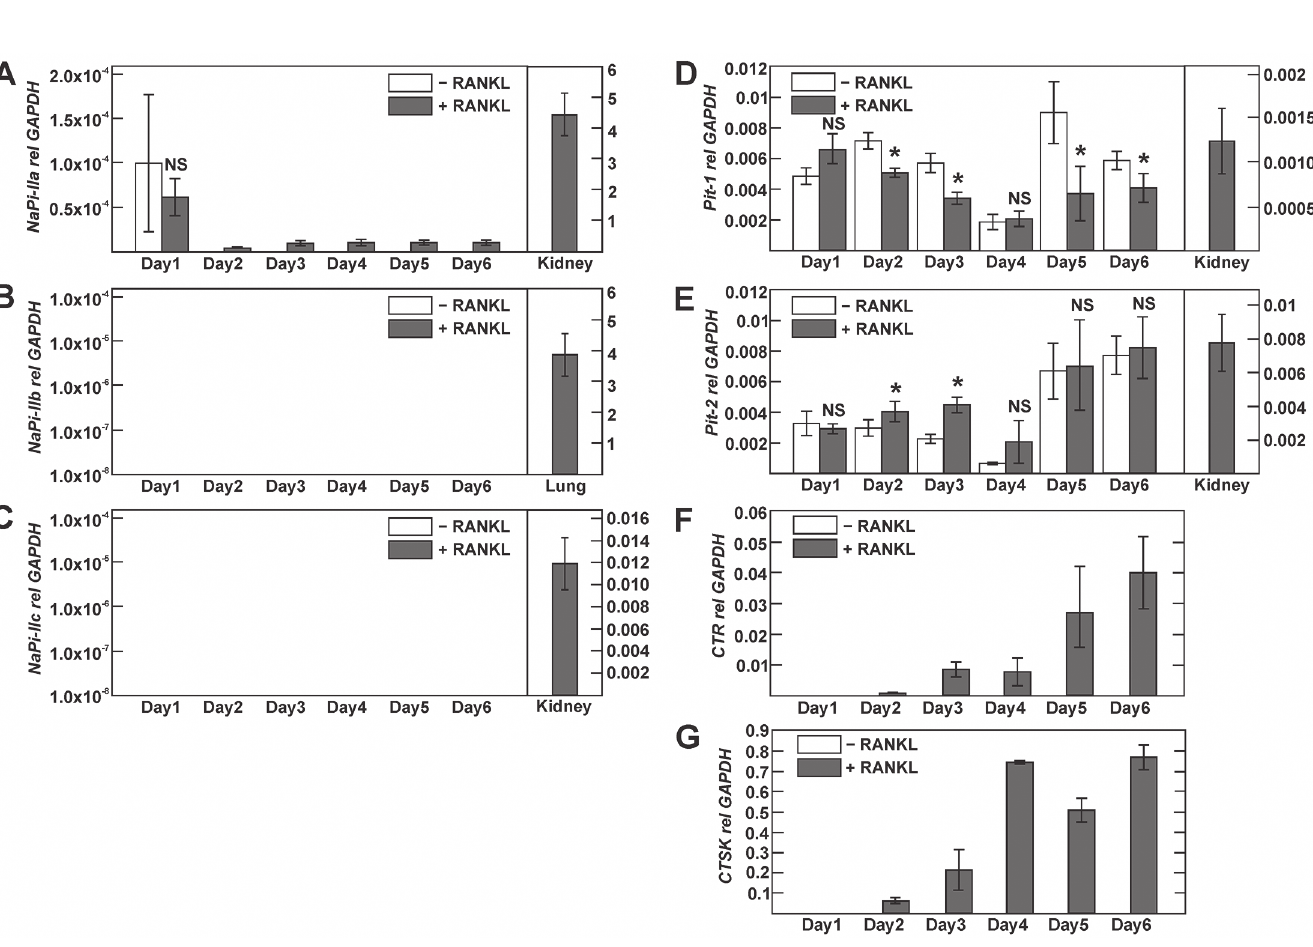
Fig 2. Expression of type I, II and III phosphate transporter isoforms during osteoclast differentiation of bone marrow-derived monocytes. Primary bone-marrow-derived monocytes (BMMs) were cultured with or without RANKL for 6 days. A-E) Phosphate transporter transcript expression was assessed by real-time PCR analysis using Taqman probes. F, G) Calcitonin receptor (CTR) and cathepsin K (CTSK) were used as markers of osteoclast differentiation. No signal was detected for NaPi-IIa in vehicle-treated BMMs at days 2 – 6 (A) and for NaPi-IIb and NaPi-IIc at any time point irrespective of the presence or absence of RANKL (not shown). Positive control PCRs in A-E were done with kidney cDNA for NaPi-IIa, NaPi-IIc, Pit-1 and Pit-2 and lung cDNA for NaPi-IIb. The amount of mRNA relative to GAPDH was calculated using the Δ Ct method. Values are shown as means ± SD; n = 3 mice/group. * p < 0.05; NS, not